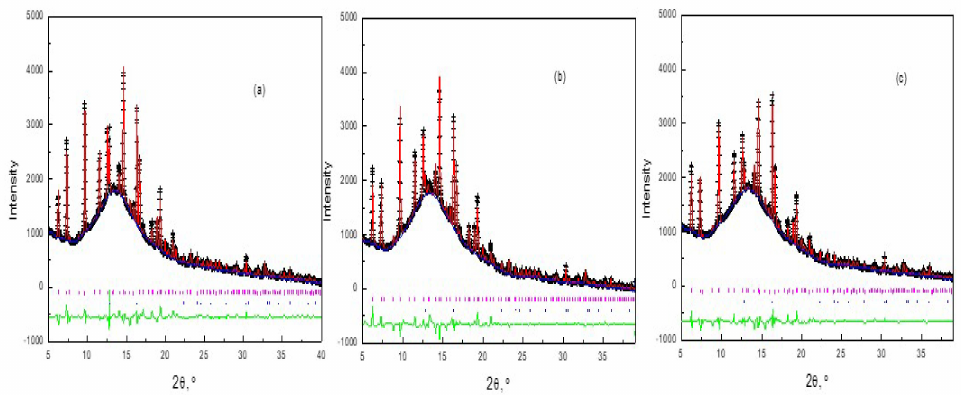
Figure 6. The Rietveld refinement of V f ( a ), V r400 ( b ), and V r450 ( c ). (+) denotes experimental data, solid red line denotes simulation curve, blue line denotes baseline, green line denotes residue, magenta bar denotes diffraction position of NaY, and purple bar denotes diffraction peak position of